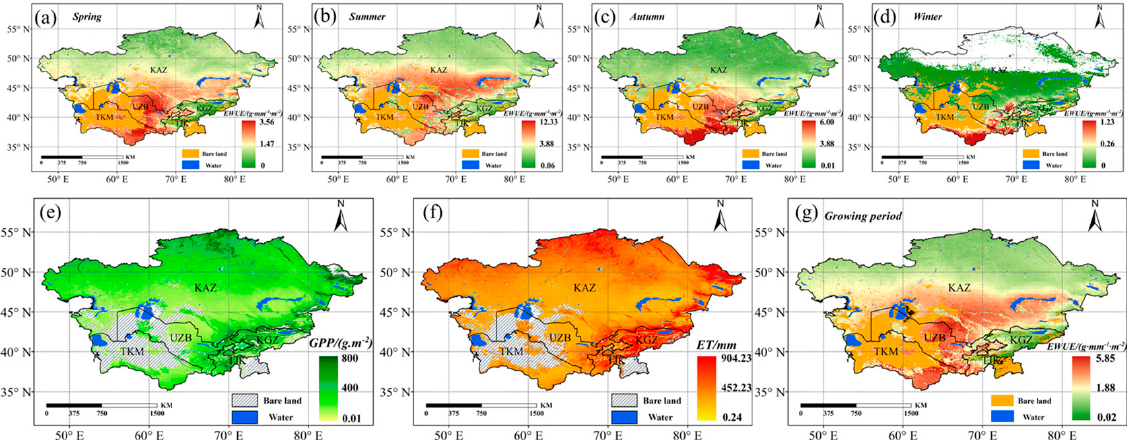
Figure 2. Spatial distribution patterns of EWUE in Central Asia from 2000 to 2018: ( a – d ) average EWUE in spring, summer, autumn and winter, ( e ) annual average GPP, ( f ) annual average ET, ( g ) average EWUE in the growing period.